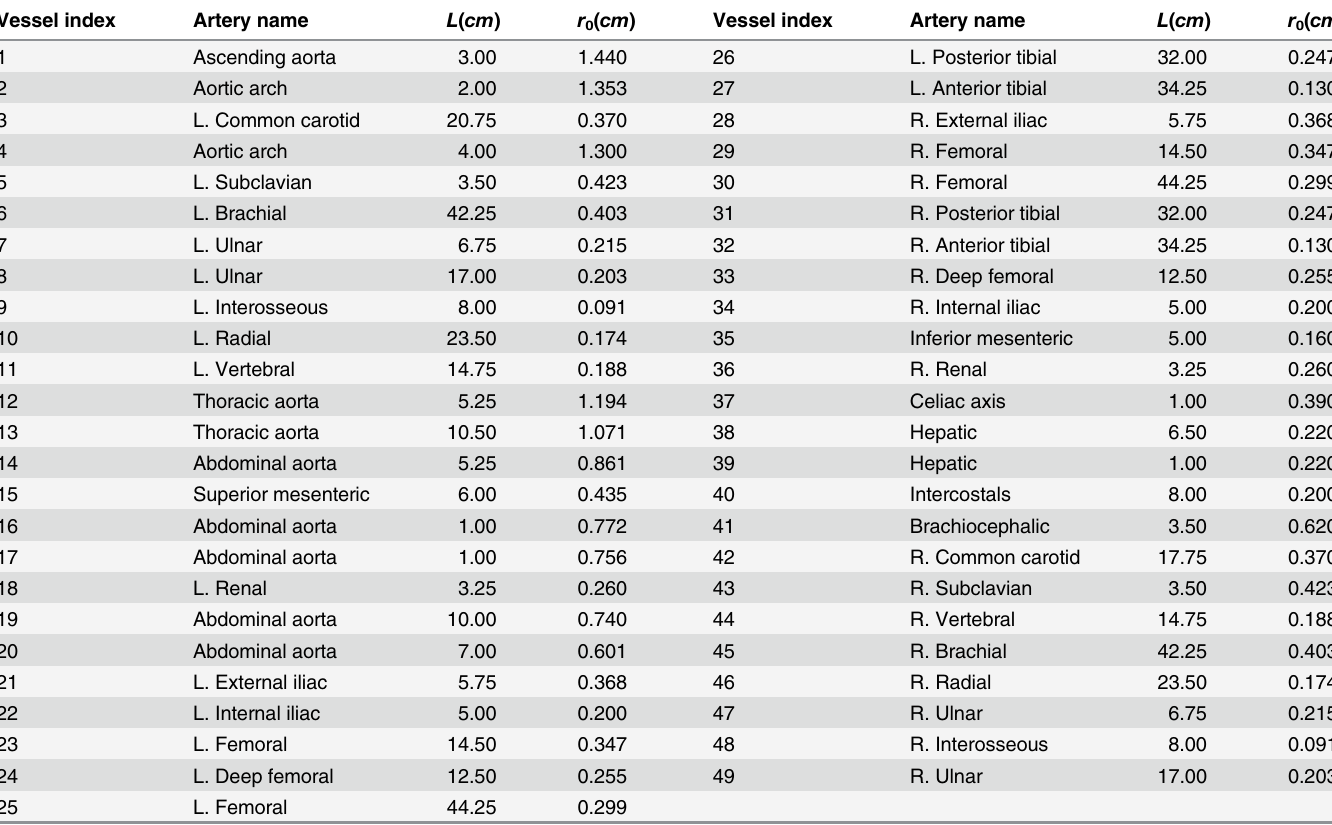
Table 2. Geometrical data of the human systemic large arterial